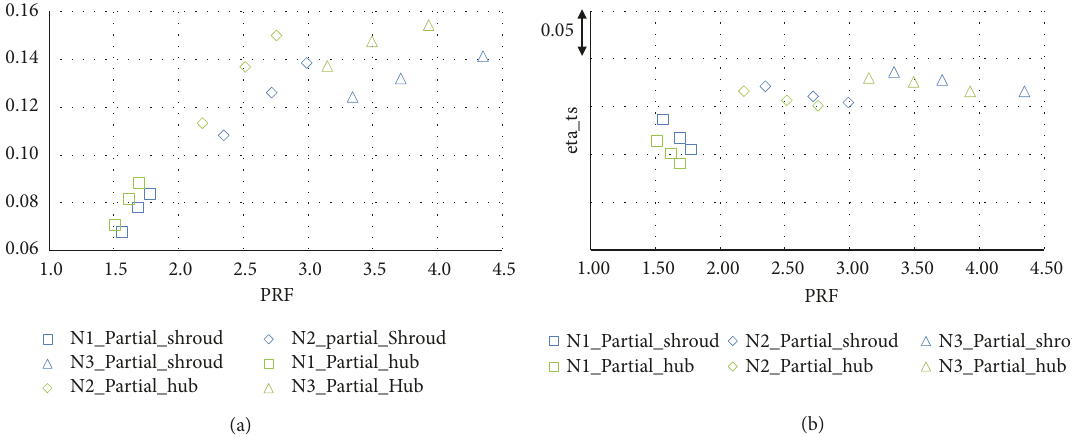
Figure 26: Performance comparison between partial shroud and partial hub with backside cavity: (a) total pressure index and (b) total-to- static